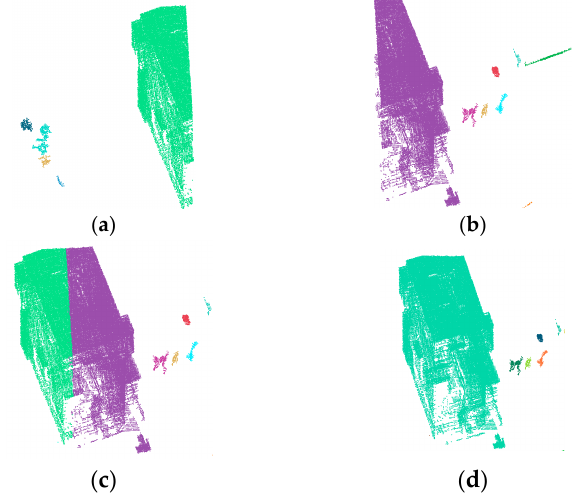
Figure 9. Objects are cut and stored in different tiles ( a ) and ( b ) during the processing of large data sets. Components have been merged in ( c ) and ( d ). ( a ) building part in one tile; ( b ) building part in another tile; ( c ) the same building part belonging to different objects; ( d ) the same building part merged into the same object.